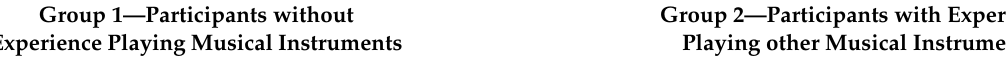
Table 2. Summary of statistical description of data: Mean values in seconds and standard